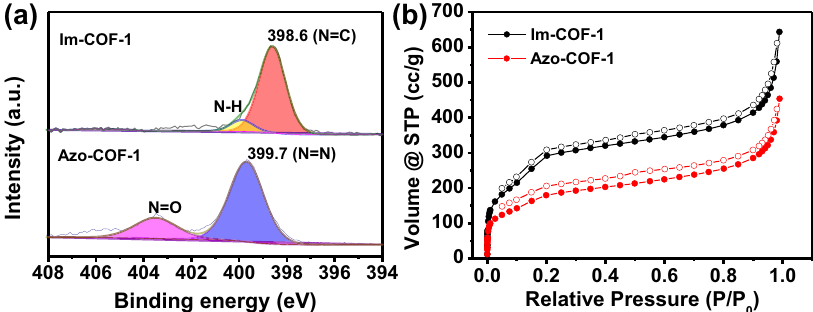
Fig. 3 XPS analysis and porosity. Comparisons of ( a ) high-resolution XPS of N 1 s and ( b ) N 2 sorption between Im-COF-1 and Azo-COF-1. Note: the supernumerary peak at 403.4 eV in the XPS spectrum of Azo-COF-1 was attributed to the N = O moieties resulting from the adsorbed monomer and residual groups 51